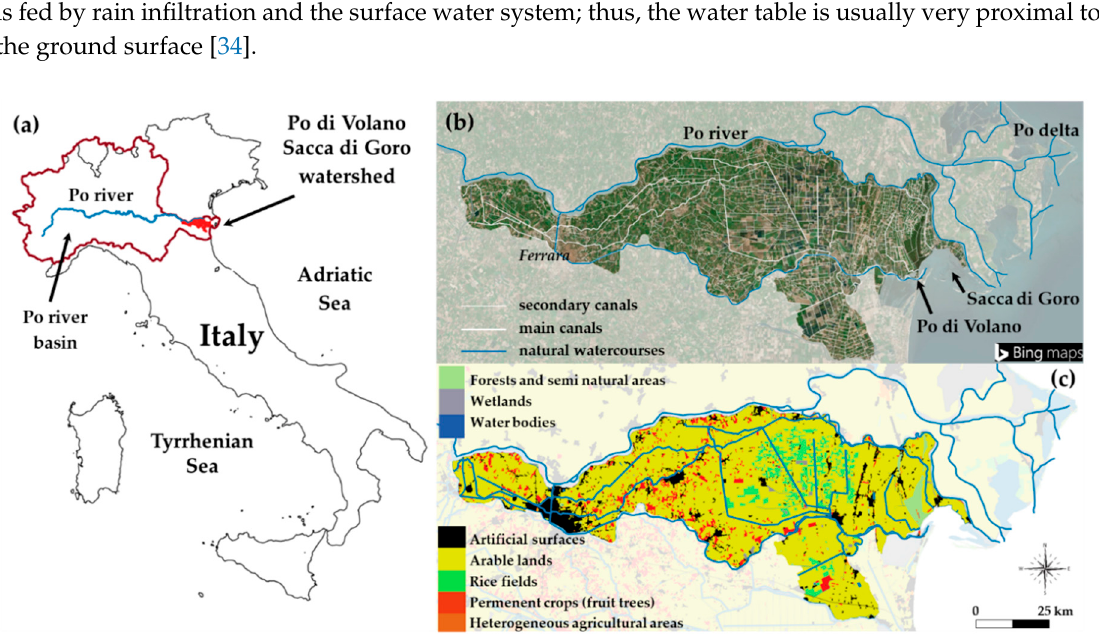
Figure 1. Study area: ( a ) location of the Po di Volano-Sacca di Goro watershed in Italy, ( b ) hydrographic network, and ( c ) map of land use/land cover (source of vector data: Emilia-Romagna Region geoportal, http://geoportale.regione.emilia-romagna.it/it; on-line Bing™ Aerial map background, Baselayer for QGIS, www.bing.com/maps).